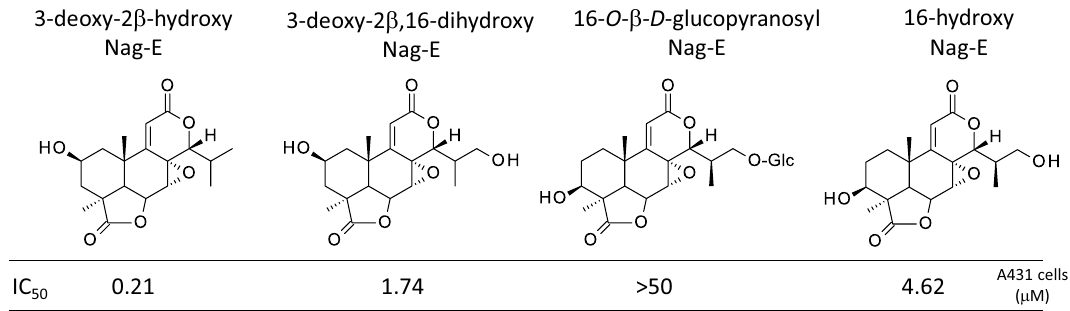
Fig. 4 Structure–anticancer activity relationships in the Nag-E series. The indicated IC 50 values (mM) correspond to the compound concentra- tions required to reduce proliferation of human epithelial carcinoma A431 cells by 50%, as described by Zheng et al.